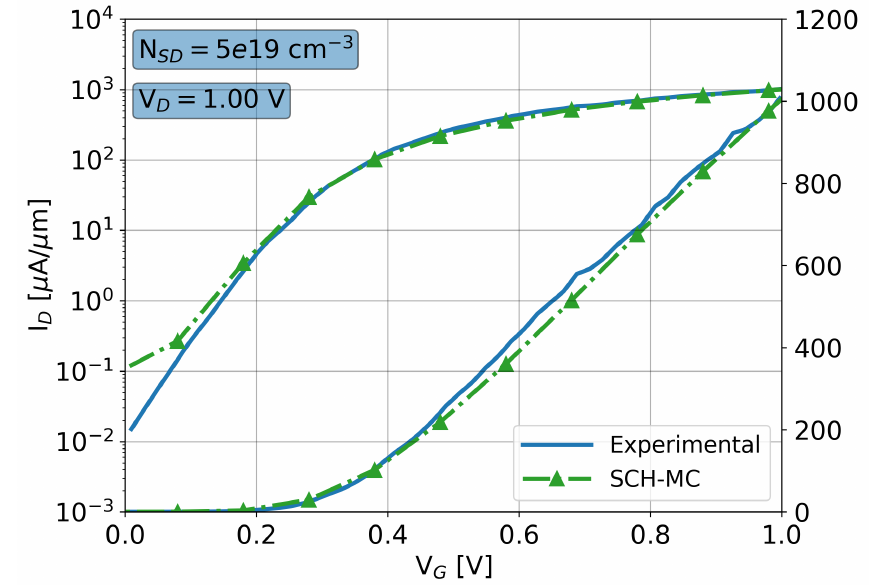
Figure 2. I D -V G characteristics for a 22 nm gate length GAA-NW FET (gate-all-around nanowire field effect transistor) at a drain bias of 1.0 V comparing experimental results from [14] against Schrödinger equation corrected Monte Carlo (SCH-MC) simulations from VENDES. The maximum source/drain Gaussian doping has been set to 5 × 10 19 cm − 3